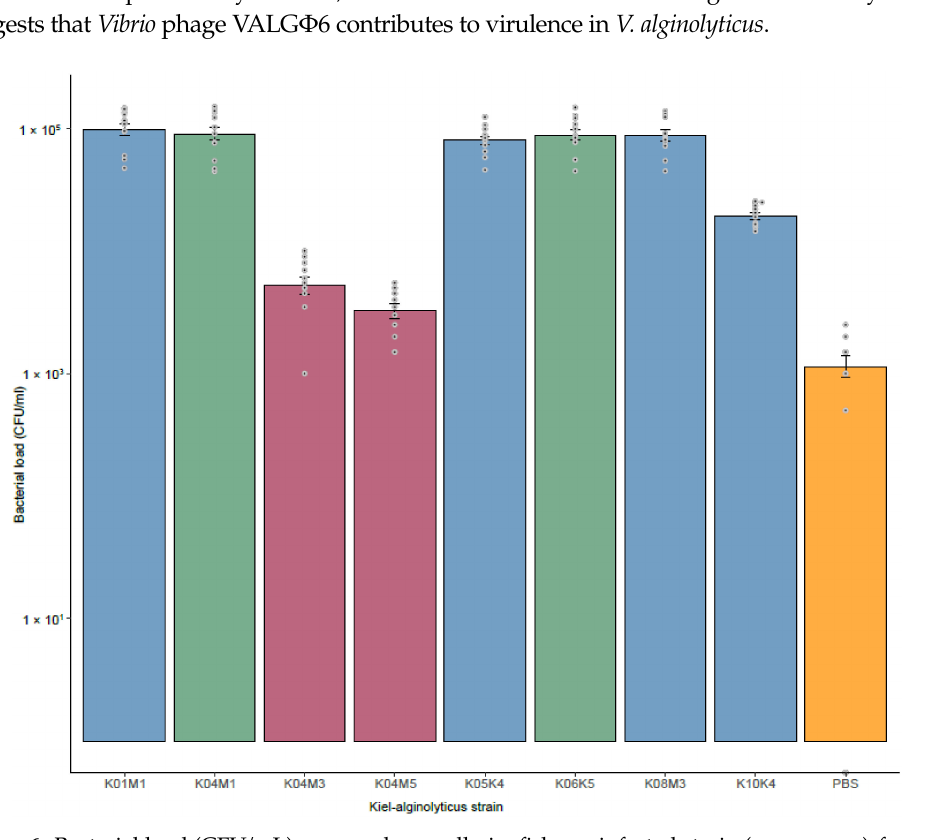
Figure 6. Bacterial load (CFU / mL) averaged over all pipefish per infected strain (mean ± s.e.) for each sequenced Kiel V. alginolyticus strain as well as PBS (orange). Strains which do not contain Vibrio phage VALG Φ 8 are color coded in blue, strains which contain Vibrio phage VALG Φ 8 but have a reduced coverage at the Vibrio phage VALG Φ 6 locus are colored in bordeaux, and strains which contain Vibrio phage VALG Φ 8 but do not have a reduced coverage at the Vibrio phage VALG Φ 6 locus are colored in